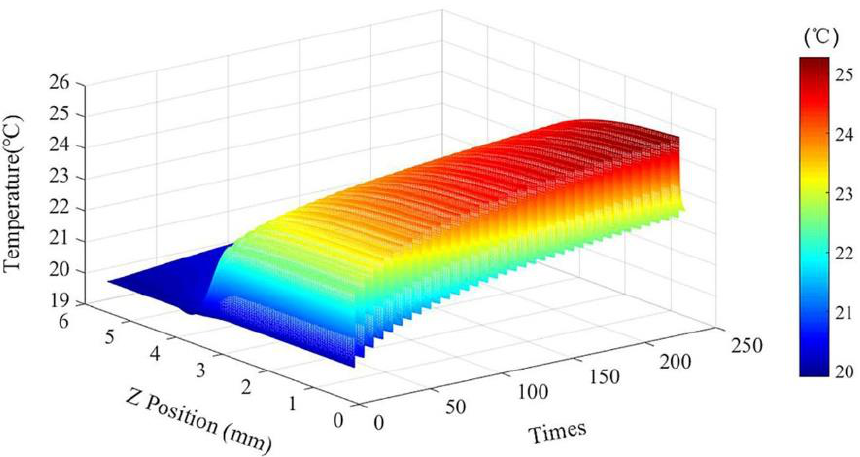
Figure 12. 3D temperature distribution of different positions of the tool edge with time. The peak temperature rose from 22.7 ◦ C to 24.9 ◦ C, and the minimum temperature rose from 20.4 ◦ C to 22.3 ◦ C, over 250 consecutive cycles (Figure